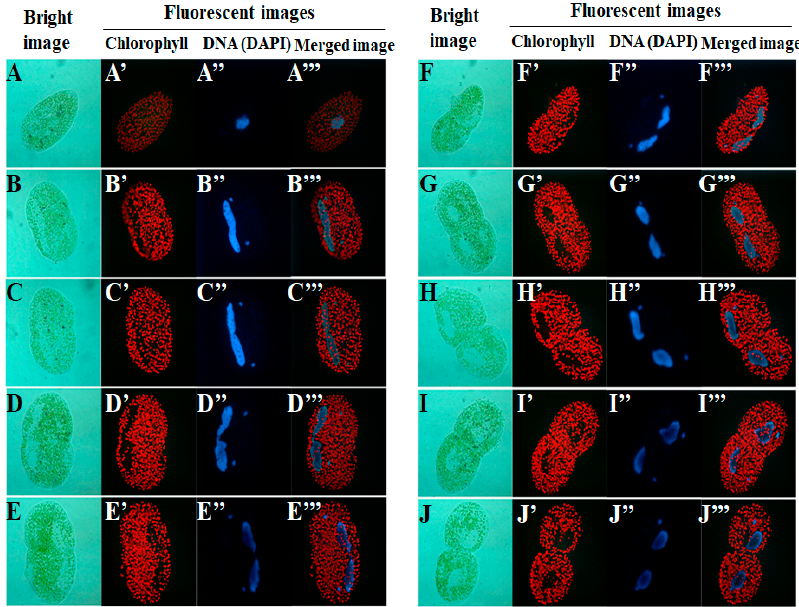
Figure 2. Morphological changes of P. bursaria through the host cell cycle. Photographs show P. bursaria from interphase ( A ) to late cytokinesis ( J ). In addition to bright field images at each stage, corresponding fluorescence images for chlorophyll of endosymbiotic algae and DAPI-staining Paramecium nuclei are shown. Here, parts (panels I and I’’’) of the photographs were referred from the literature [15]. Others present unpublished data from a study of the literature [15].